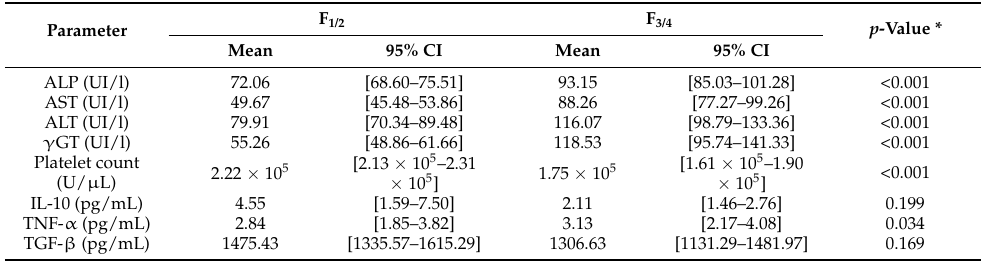
Table 1. Association of baseline biochemical and cellular parameters and cytokines (continuous variables) with fibrosis stage before DAA